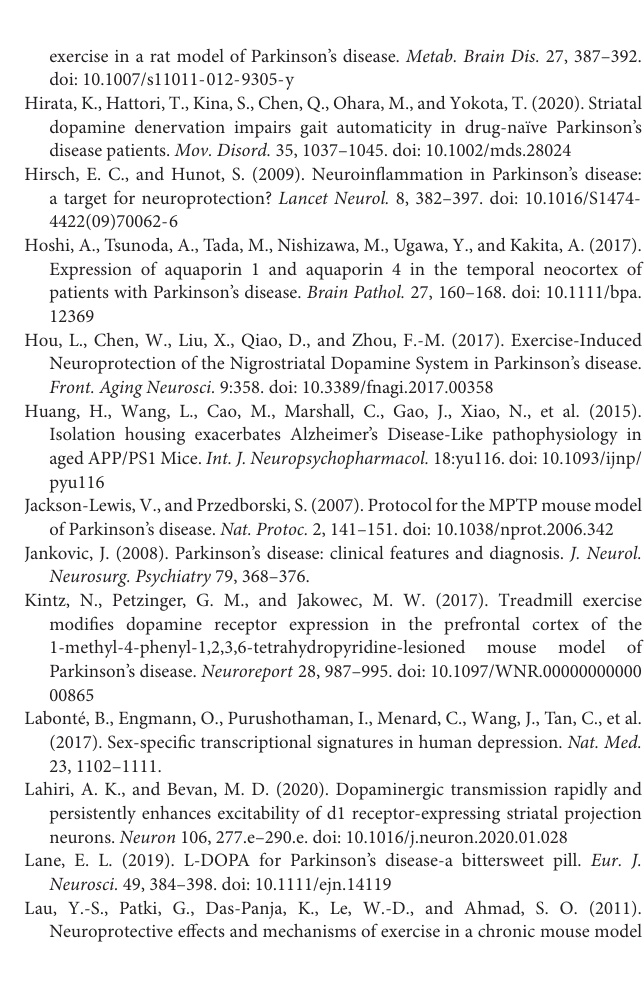
Supplementary Figure 1 | Heatmaps of differentially expressed genes (DEGs) in cerebellum (A) , cortex (B) , SN (C) , and striatum (D) . The color bar represents log 2